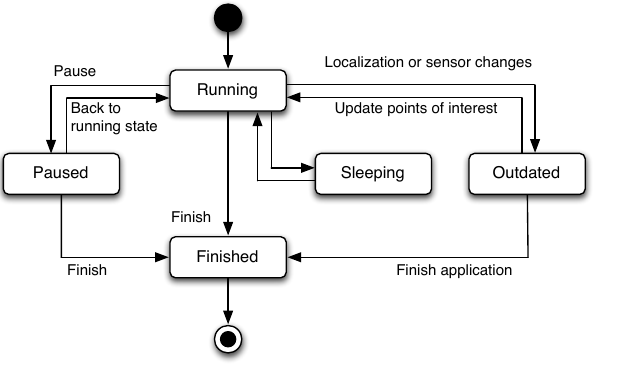
Fig. 3. Application’s life-cycle.